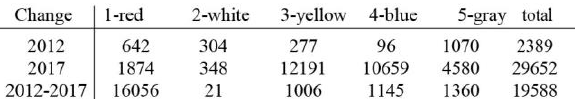
Figure 9. The unsupervised change-map between 2006-2017, The difference images is computed in such a way that the resulting image has the pixel where changes are effective with a high gray level instead of the pixel where the changes are Figure 7. Combined difference image of 2006 - 2017 irrelevant or absent with a low gray level. outperforms